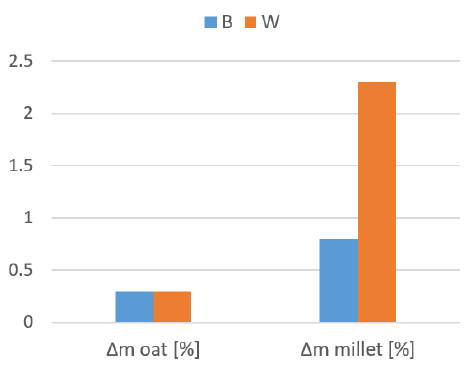
Figure 3. Mass loss test results of oat and millet husk-reinforced composites after exposure to Coni- ophora puteana and manual mycelium removal with a soft brush (B) and with water under pressure (W). The results are expressed in %. Bending Strength and Modulus of Elasticity after Exposure to Coniophora Puteana The test results of the specimens’ mechanical properties show that in the initial state, the composites reinforced with oat and millet husk had a bending strength of 44 MPa and 31 MPa, respectively, while the specimens’ modulus of elasticity was 3790 MPa and 2870 MPa, respectively (Figure 4). It can be noticed that the properties of the composite with oat husks are more useful than those of the composite with millet husks in the initial state. The reason for this may be the influence of the shape and wetting degree of the filler. Oat fillers have an elongated shape, which is advantageous for their mechanical properties. In general, millet fillers have irregular shapes [20]. In addition, fillers naturally have different moisture absorption capacities. ( a ) ( b ) Figure 4. Test results of ( a ) bending strength and ( b ) modulus of elasticity of oat and millet husk- reinforced composites after exposure to Coniophora puteana and manual mycelium removal with a soft brush (B) and with water under pressure (W). Test results of reference specimens in initial state (R) have been also presented. The results are expressed in MPa. The test results of the composites obtained after 14 days of soaking in water, followed by 4 months of exposure to fungi at 22 °C and at 70% humidity, show that these conditions reduce their flexural strength and modulus of elasticity, compared to the reference mate- rial. This was also reported in other papers [8]. The method of cleaning had a small effect on the oat husk composite. After exposure to fungus and cleaning with a brush, the oat husk composite had a bending strength of 40 MPa and a modulus of elasticity of 2460